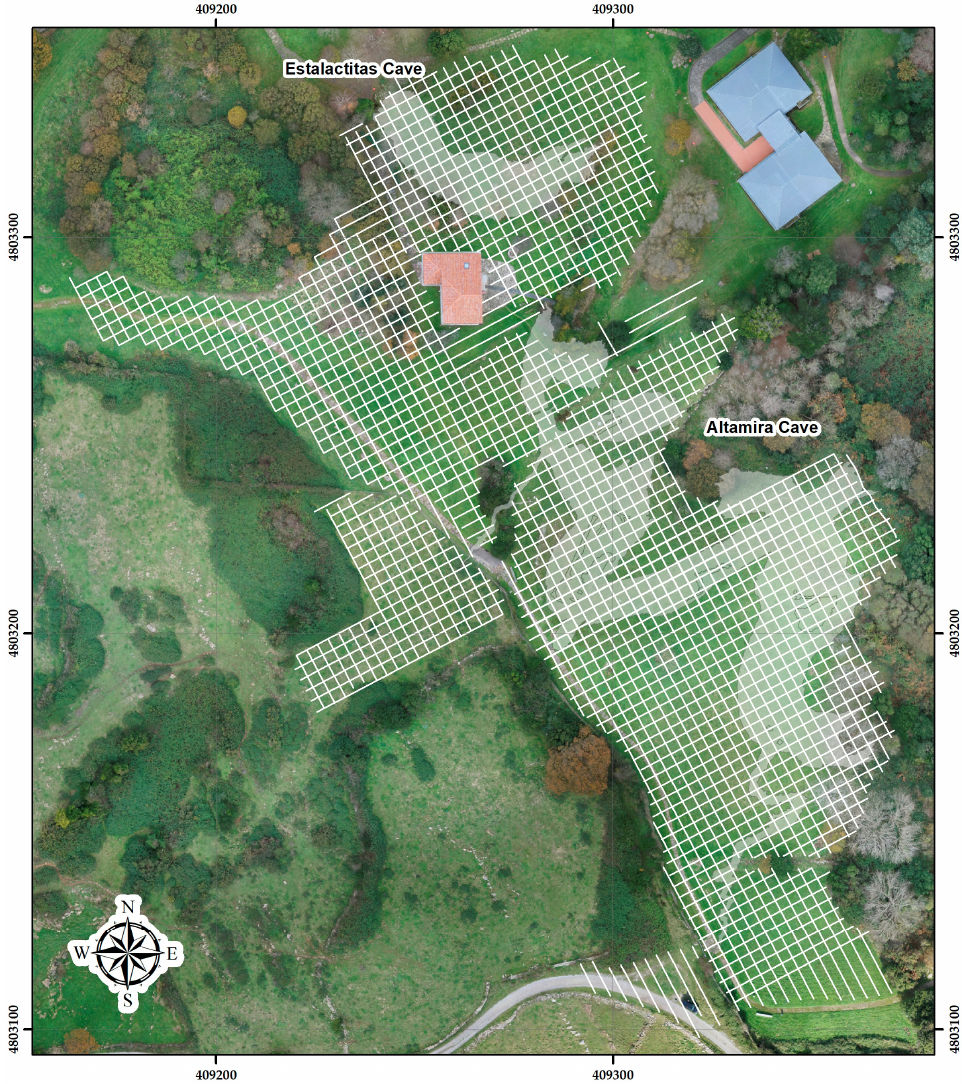
Figure 5. The location of GPR profile grid (orthogonal 2D profiles spaced every 3 m) in the Altamira Cave site, carried out with the 100 MHz antenna.